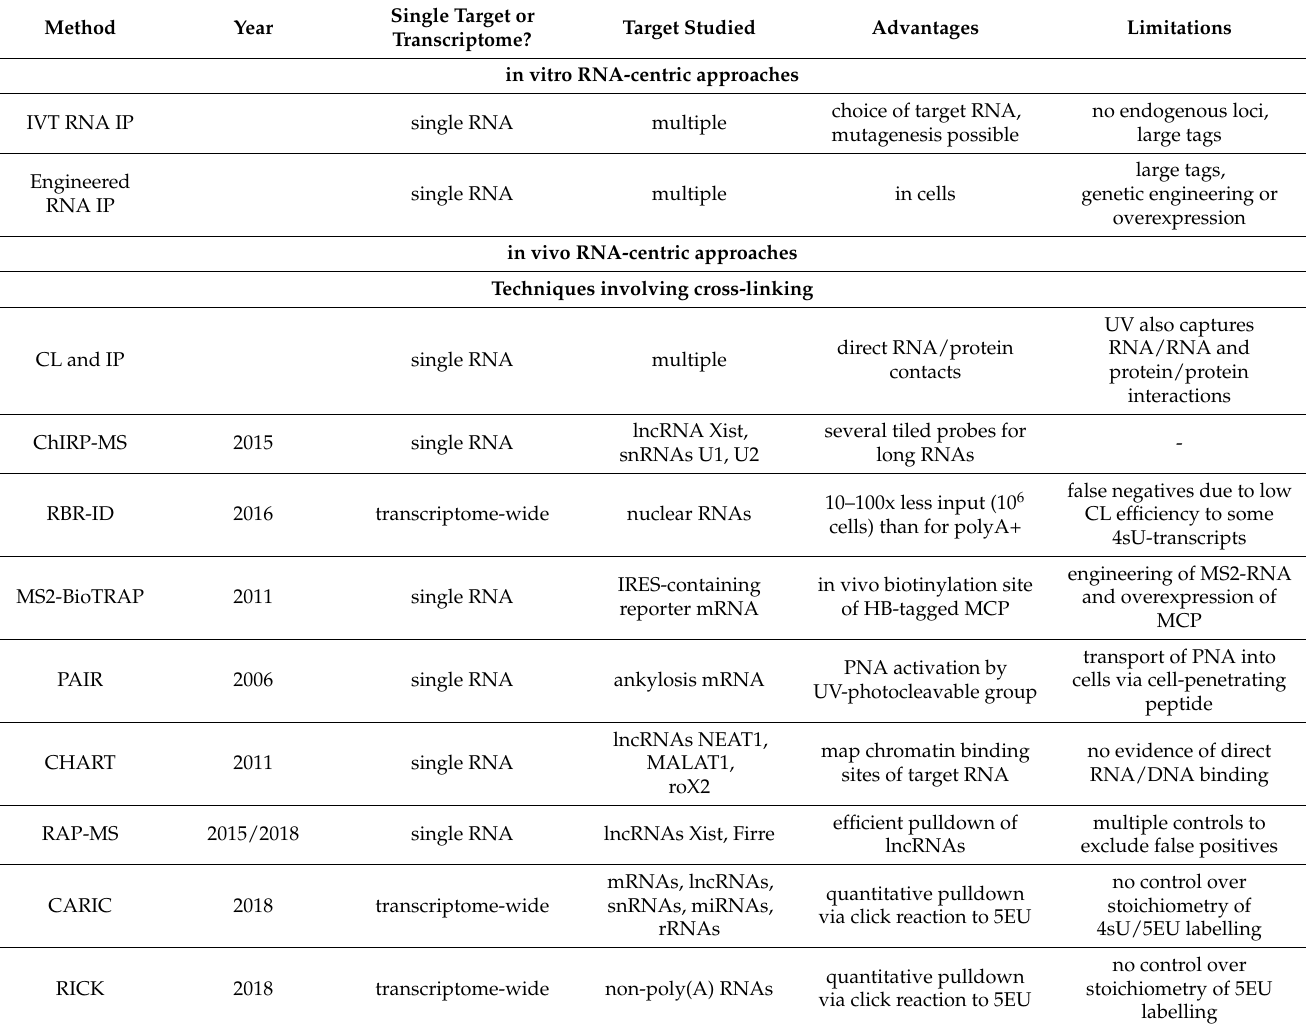
Table 1. Summary of techniques to study RNA–protein interactions covered in this review. Year of development, target studied, advantages and limitations are